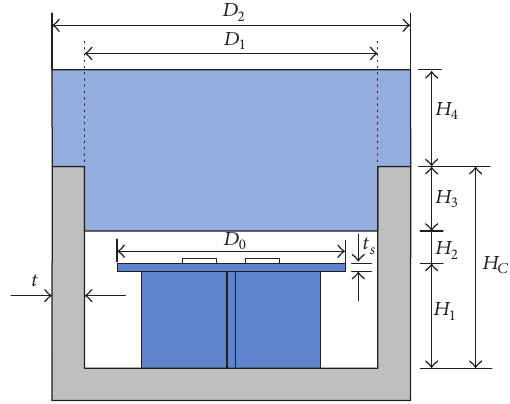
Figure 2: Design parameters of the proposed feed.